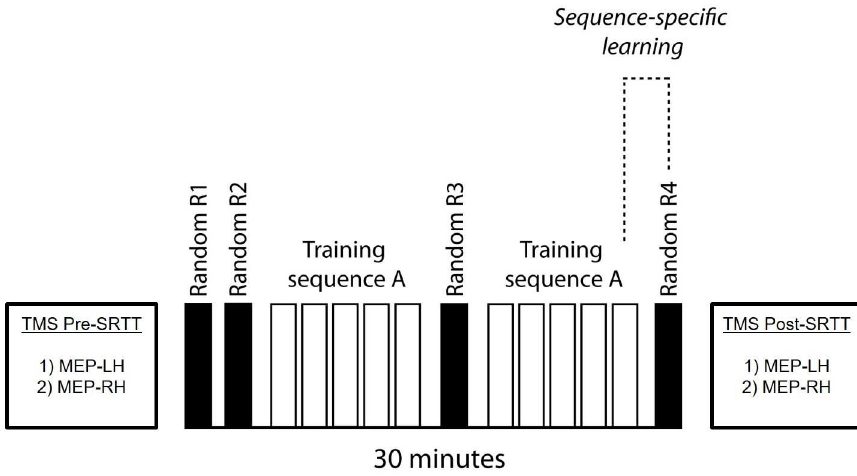
Fig 1. The order of the random (R) and training blocks (A) during the SRTT task is displayed. For all participants, Motor Evoked Potentials (MEP) were measured with TMS before (Pre-SRTT) and after (Post- SRTT) the SRTT over the FDI muscle representation in the left (LH) and right (RH) M1, beginning with the left hemisphere.